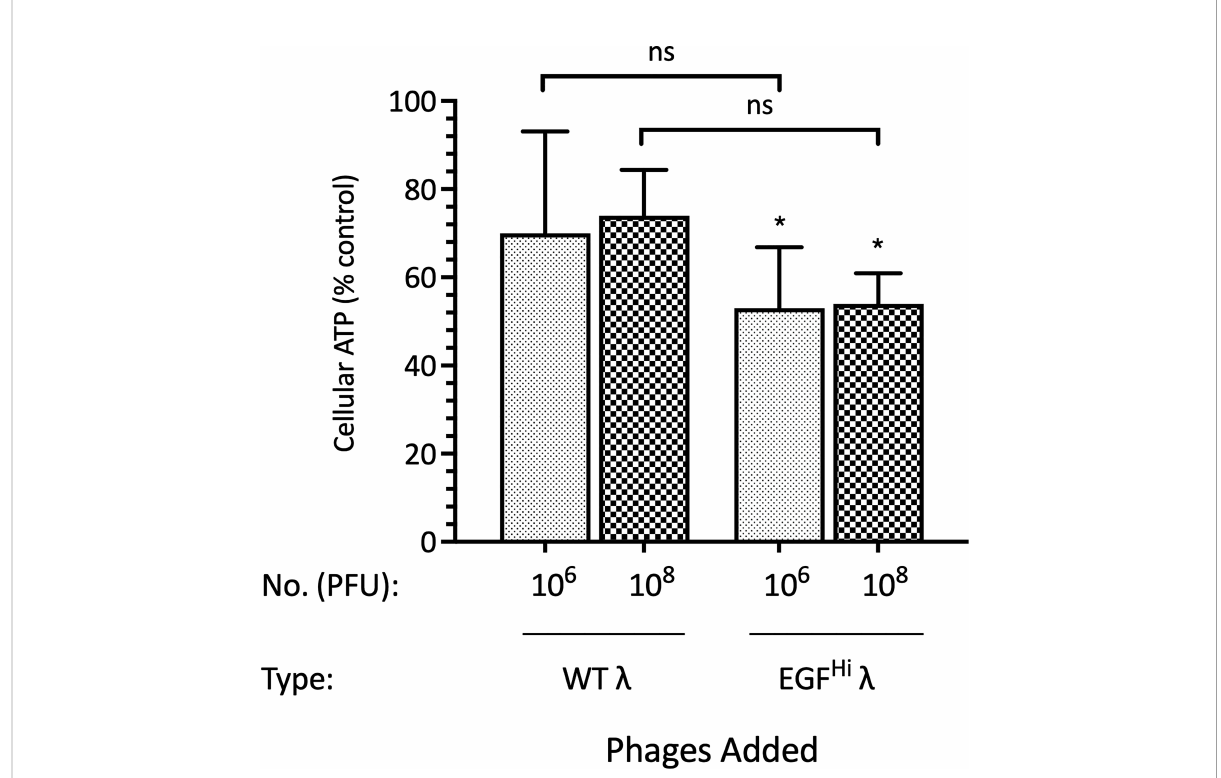
FIGURE 7 EGF decoration of l phages leads to a reduction in the ATP of HT-29 cells in spheroids. HT-29 spheroids (d7) were treated with 10 6 or 10 8 PFU of WT l or EGF Hi l phages for 24 h. The ATP content of spheroids was then determined. Data are expressed relative to spheroids in standard growth medium, as mean ± SEM of 3 independent experiments, each with 3 culture replicates. Signi fi cantly difference from control, * P<0.10; ns, not signi fi